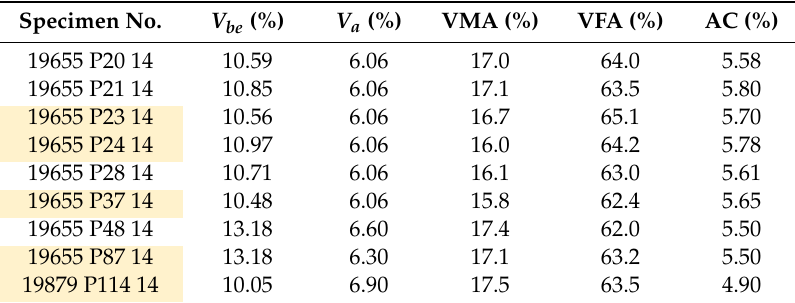
Table 3. Volumetric information of the SX(100) PG 64-28 mix.